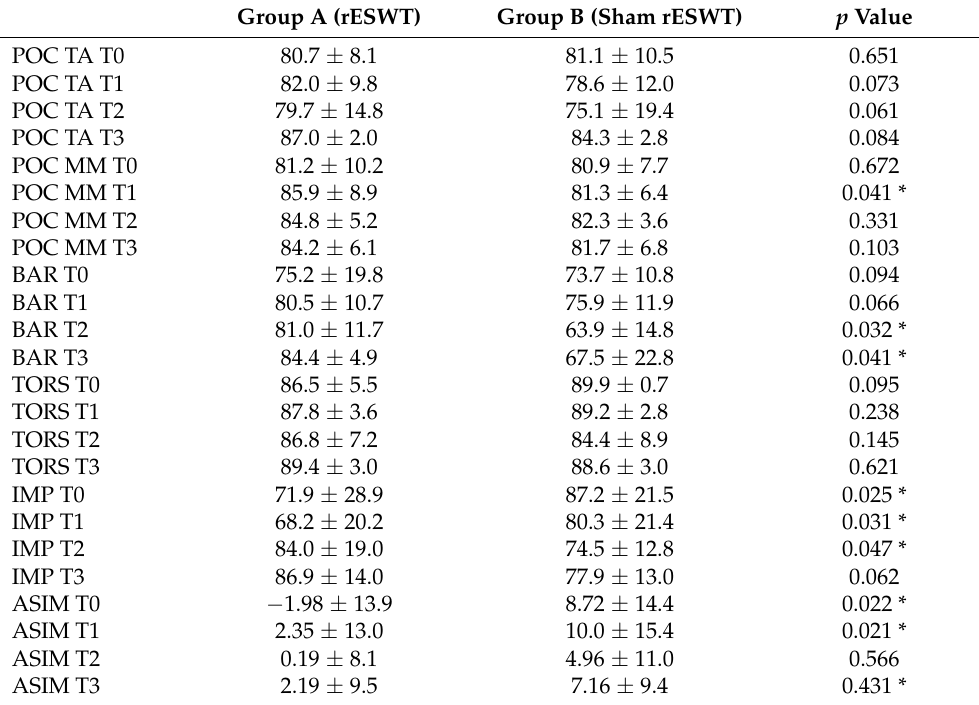
Table 3. Between-group differences in muscle activity assessed by surface